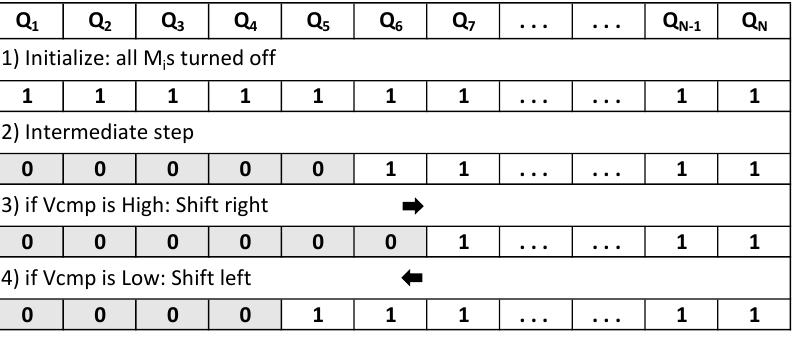
Figure 3. Operation principle of the shift register utilized in the